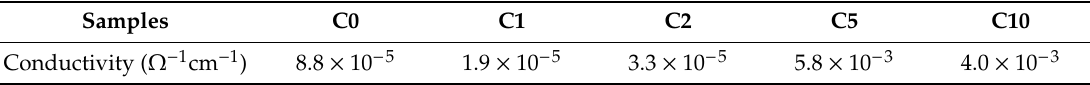
Table 1. Electrical conductivity of each sample measured with the four-point probe method.